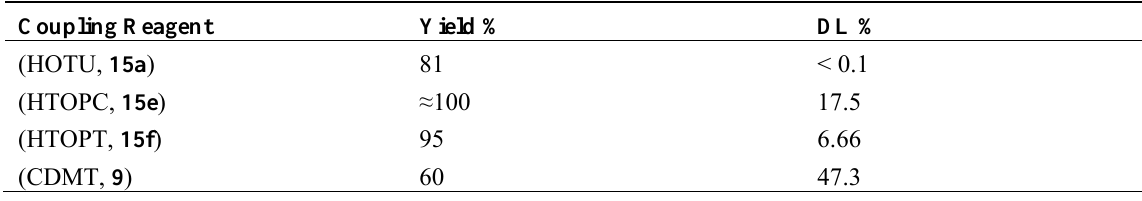
Table 5. Yield (%) and Racemization (%) of Z -Gly-Val-Val-OMe ( 17c ) using the Uronium Salts 15a,e,f and CDMT ( 9